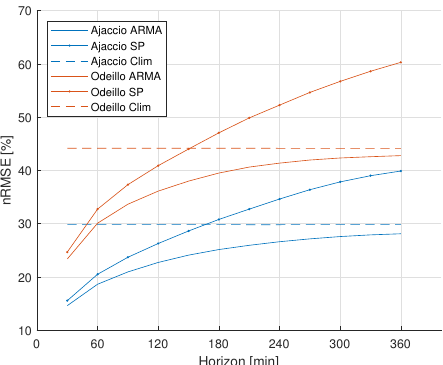
Figure 5. nRMSE for the two sites and for Auto Regressive Moving Average (ARMA), Scaled Persistence and Climatology models for a 30 min time-step.